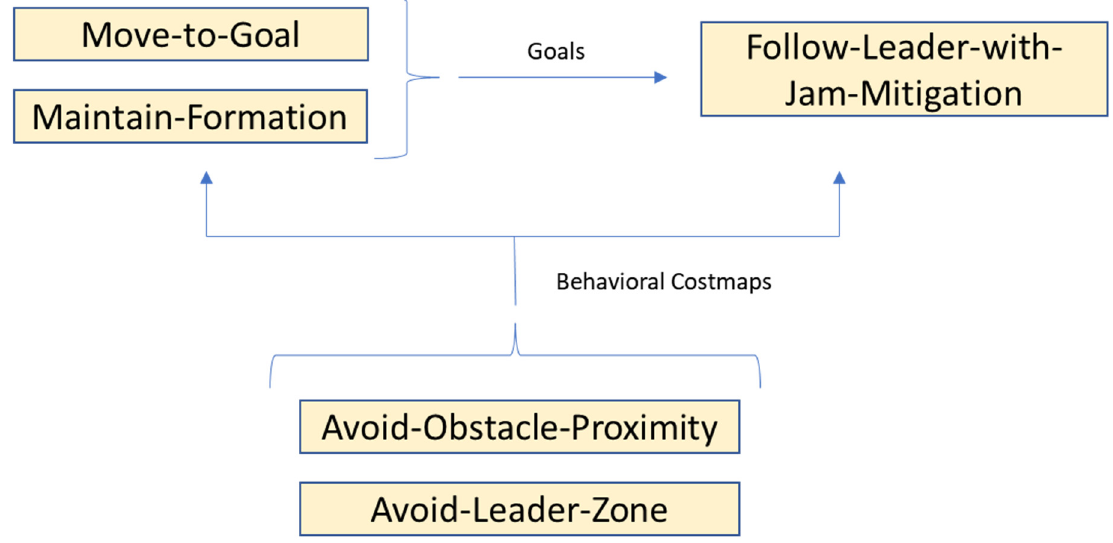
Figure 13. Architecture of the Follow-Leader-with-Jam-Mitigation assemblage.